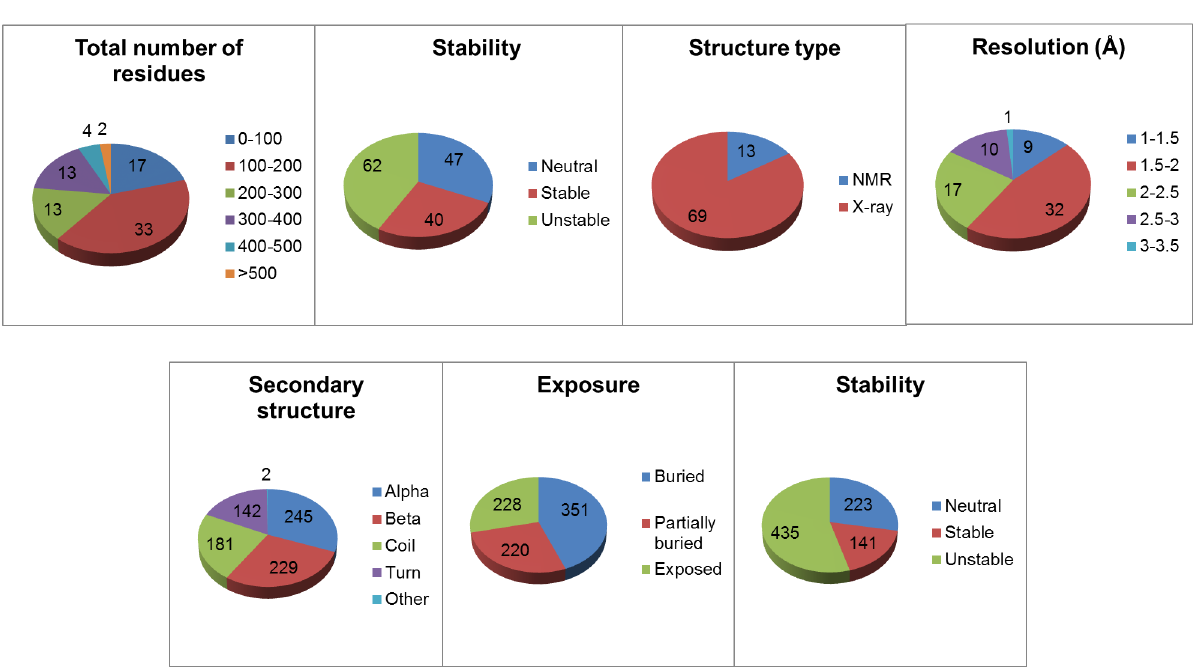
Fig 3. The diversity of protein structures (top 4 charts) and point mutation residues (bottom 3 charts) in the dTm data set. The sum of all proteins in the “ Stability ” pie chart is greater than the total number of proteins in Table 1, because some proteins have multiple mutations in different stability categories i.e. stable, neutral, or unstable. The “ Resolution ” chart only has data from proteins which have crystal structures. An NMR structure doesn ’ t have a resolution.